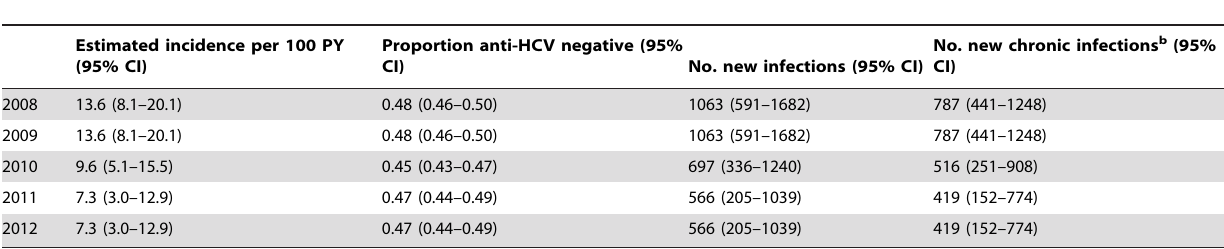
Estimated incidence per 100 PY (95% CI)